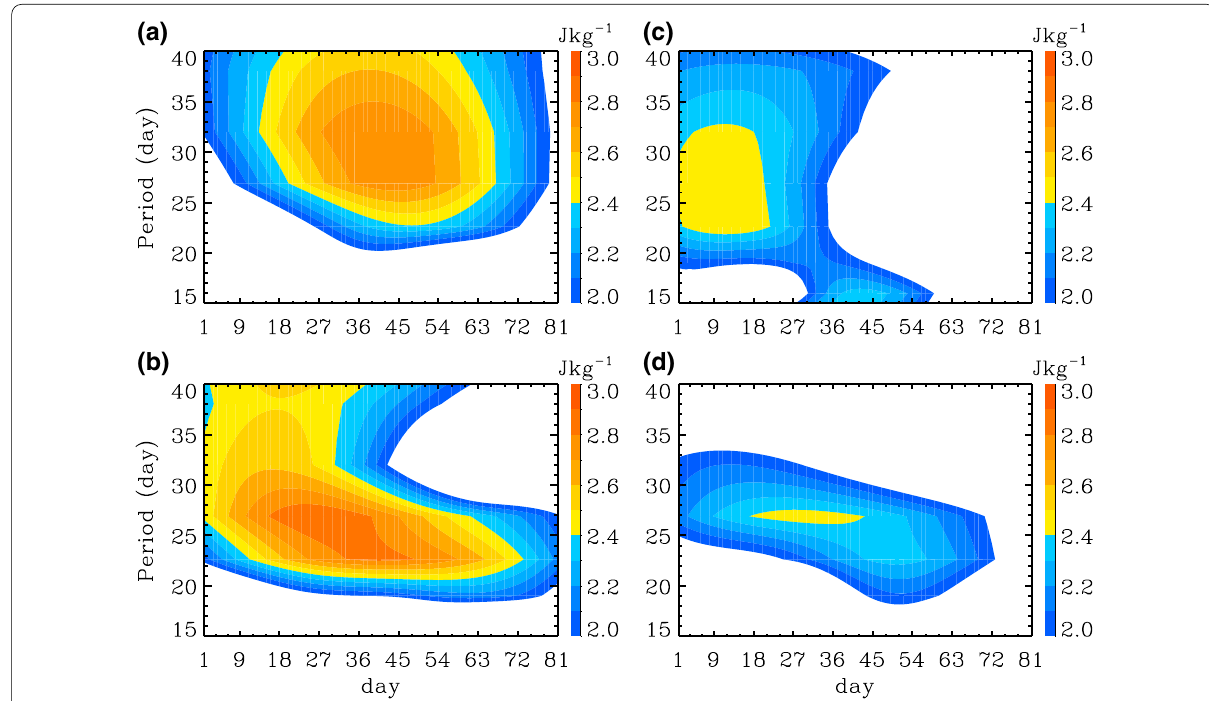
Fig. 8 Wavelet spectra of daily mean GW energies at a , c 1–9 km and b , d 20–28 km derived from radiosonde observations. a , b Represent the spectra of GW energy averaged between Hilo and Kauai, and c , d represent the spectra of GW energy in Pago